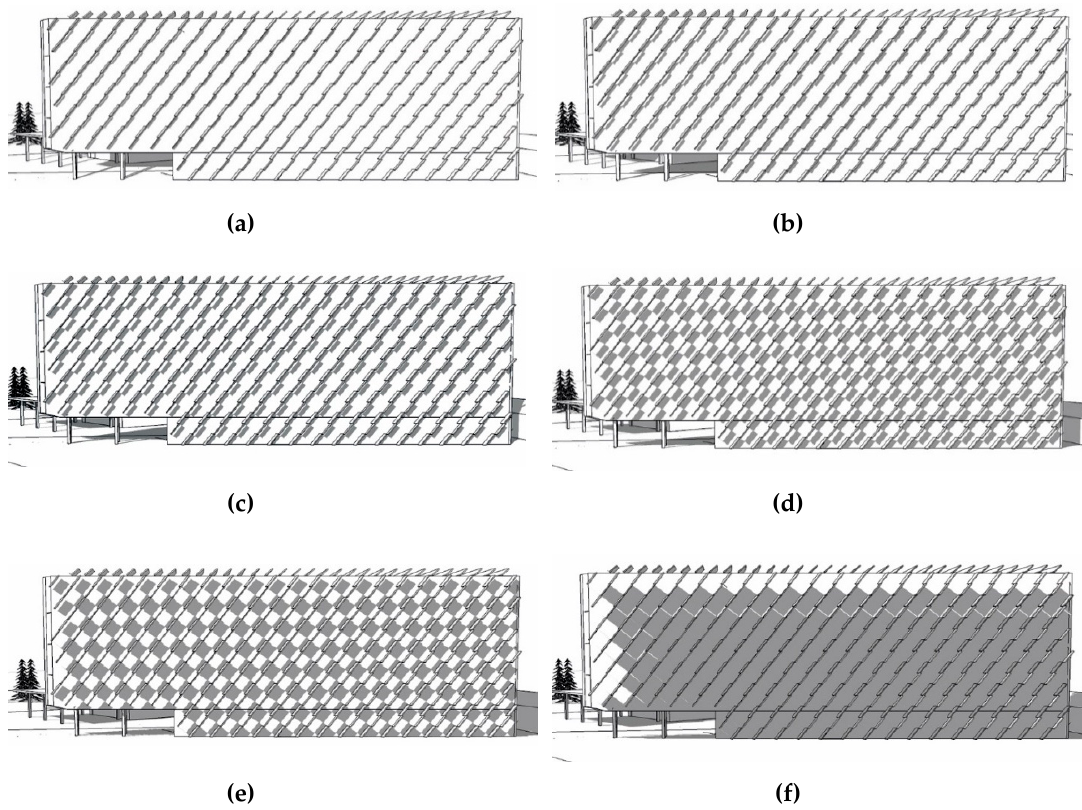
Figure 16. Hourly sequential shading of an office building fitted with PV panels on the east façade ( a ) At 7.00 a.m.; ( b ) At 8.00 a.m.; ( c ) At 9.00 a.m.; ( d ) At 10.00 a.m.; ( e ) At 11.00 a.m.; ( f ) At 12.00 a.m. (by P. Filipek).